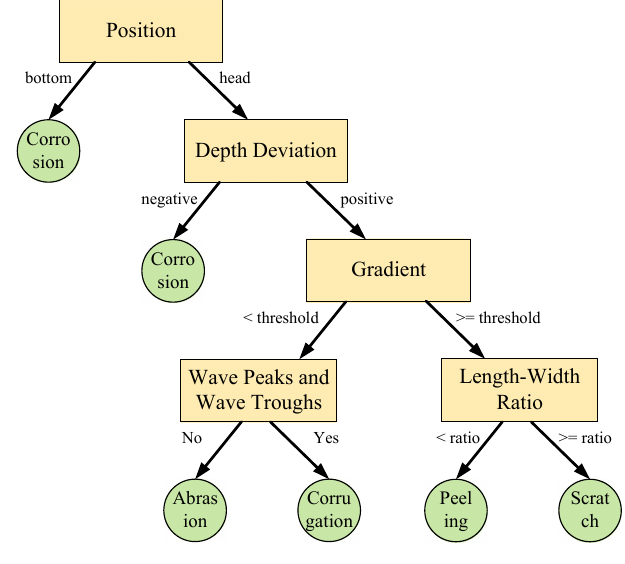
Figure 7. Decision tree